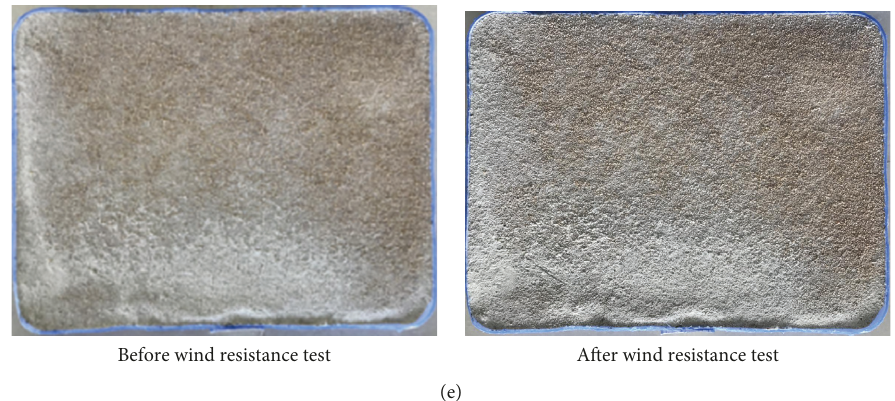
Figure 6: Photos of sand specimens before and after wind resistance tests: (a) no. 0; (b) no. 1; (c) no. 2; (d) no. 3; (e) no. 4.